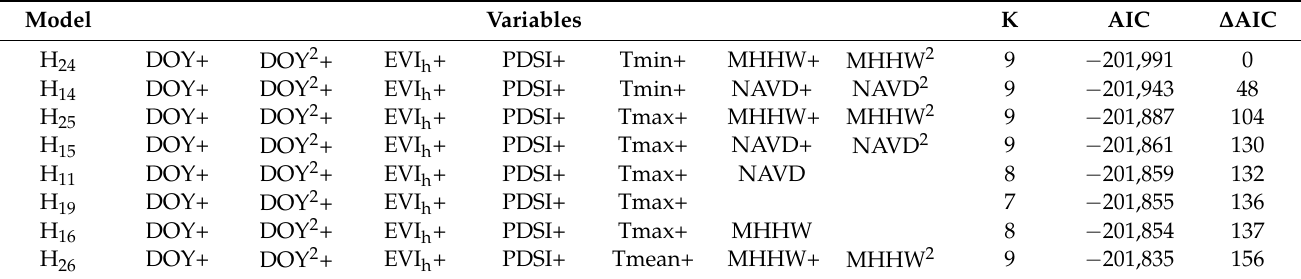
Table A1. Models used to estimate EVI for 2019. The model with the lowest AIC value is considered the best fit model. The K value is the number of parameters within the model, and ∆ AIC is the difference between the AIC value for the given model and the AIC value from the best fit